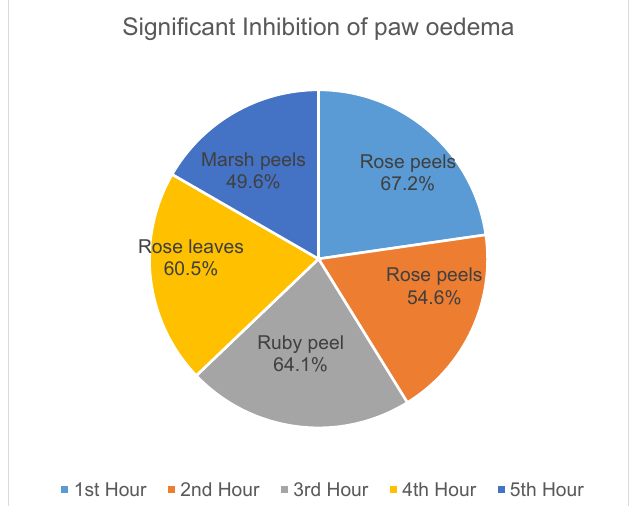
Figure 7. Summary of most active anti-inflammatory cultivar per hour.